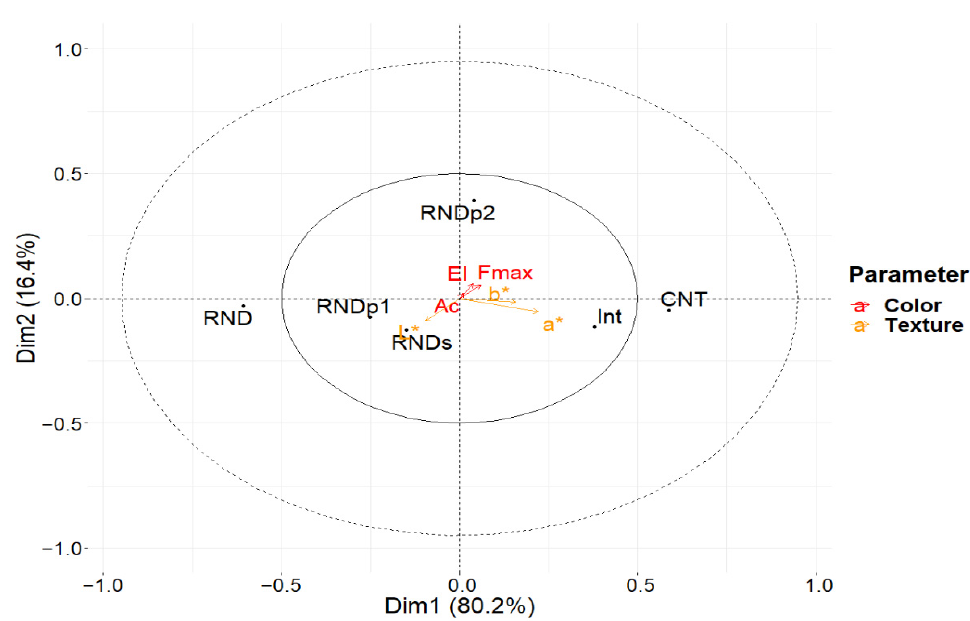
Figure 9. Biplot for ASCA showing the values for the first two principal components for the LMM- ASCA decomposition of the factor “Sampling Position”. Score values for each level are represented by black dots, each label corresponds to a different sampling position: “RND”: round; “RNDs”: round central; “RNDp1”: external plate; “Int”: intermediate zone; “RNDp2”: internal plate; “CNT”: center. Loading values are represented using arrows for each parameter acquired, and colored according to the type of the measurement: “El” stands for elastic modulus; “Ac” for area under the curve; “Fmax” for maximum force; “L*”, “a*”, and “b*” labels are referred to the coordinates of the lab color spaces.